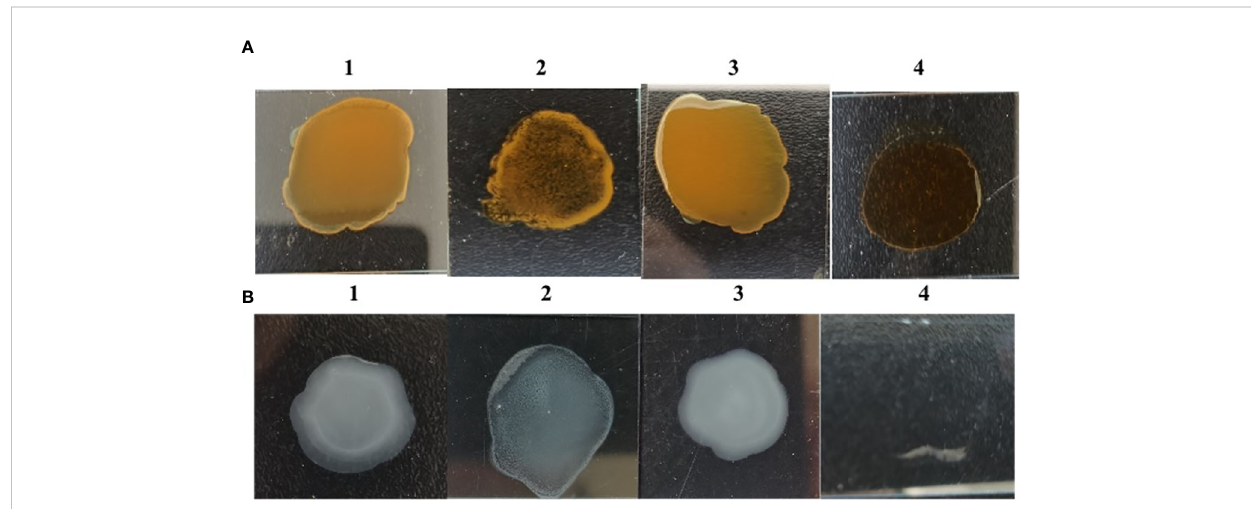
S584 D galU R displayed a fl ake stacking distribution (Figure 6A). The results of Crystal Violet bio fi lm staining showed that